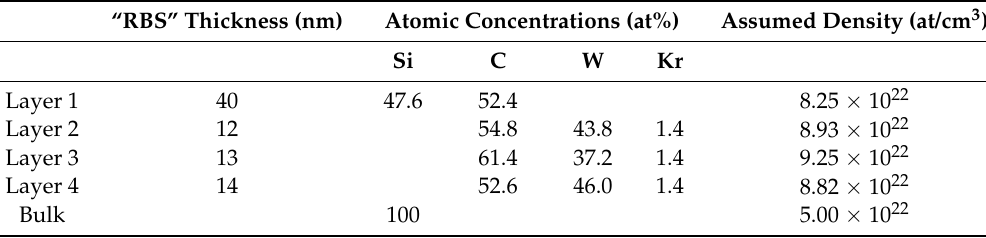
Table 6. Thickness, atomic concentrations and assumed densities of SiC (layer 1) and WC (layers 2–4) and Si substrate (bulk) after annealing at 700 ◦ C for 24 h as determined from RBS analysis and fits. “RBS” Thickness (nm) Atomic Concentrations